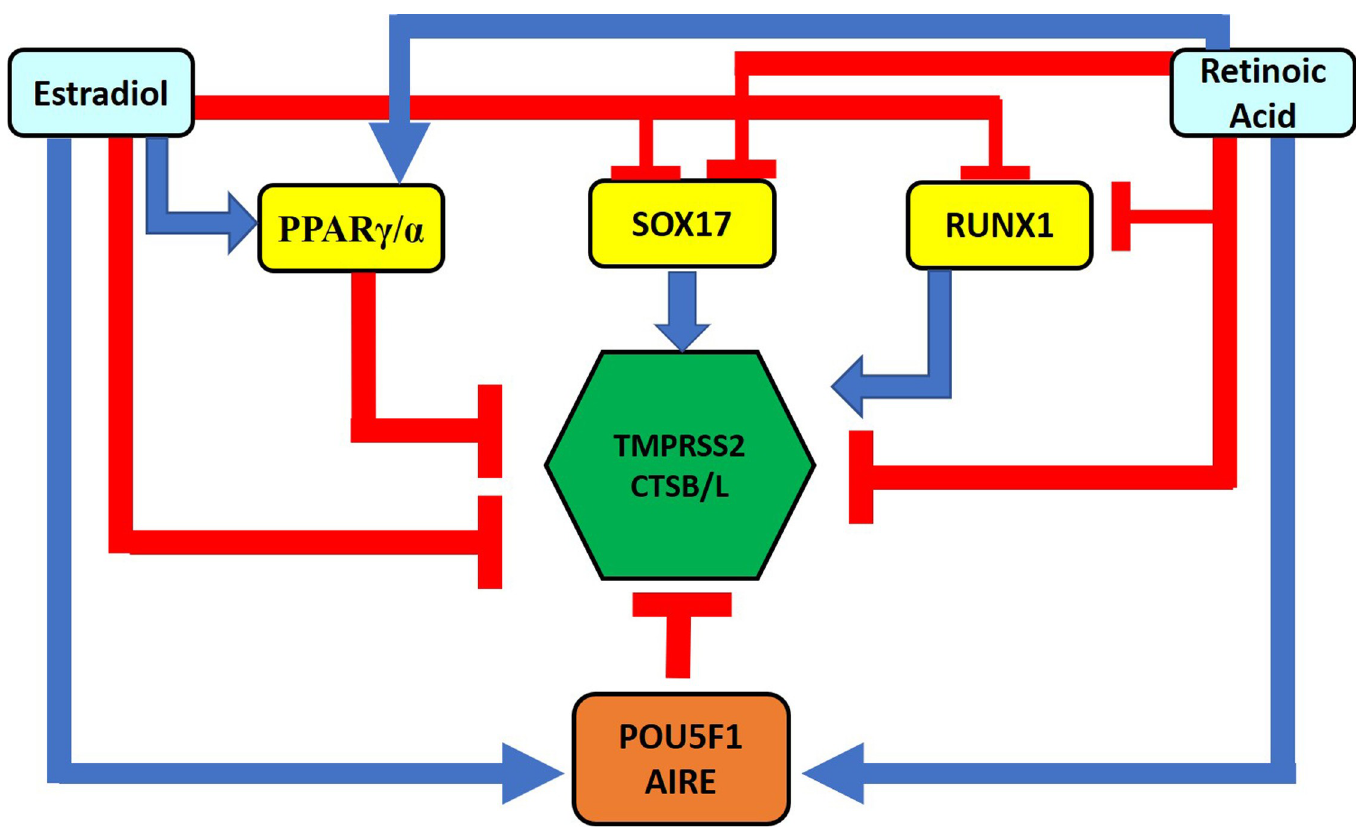
Fig 3. Summarized results of GSEA and GEO analysis. The figure represents PPAR γ and PPAR α as repressors while SOX17 as an activator of TMPRSS2 and CTSB/L gene expression. On the other hand, RUNX1 acts both as an activator and repressor of TMPRSS2 and CTSB/L genes. Two transcription factors, POU5F1 and AIRE downregulate the gene expression of TMPRSS2 and CTSB/L. The figure also depicts the effects of estradiol and retinoic acid on modulators of TMPRSS2 and CTSB/L expression. Both estradiol and retinoic acid upregulate the expression of PPAR γ and PPAR α , POU5F1 and AIRE, while downregulates the expression of SOX17 and RUNX1. Also, estradiol and retinoic acid downregulate the expression of TMPRSS2 and CTSB/L genes.